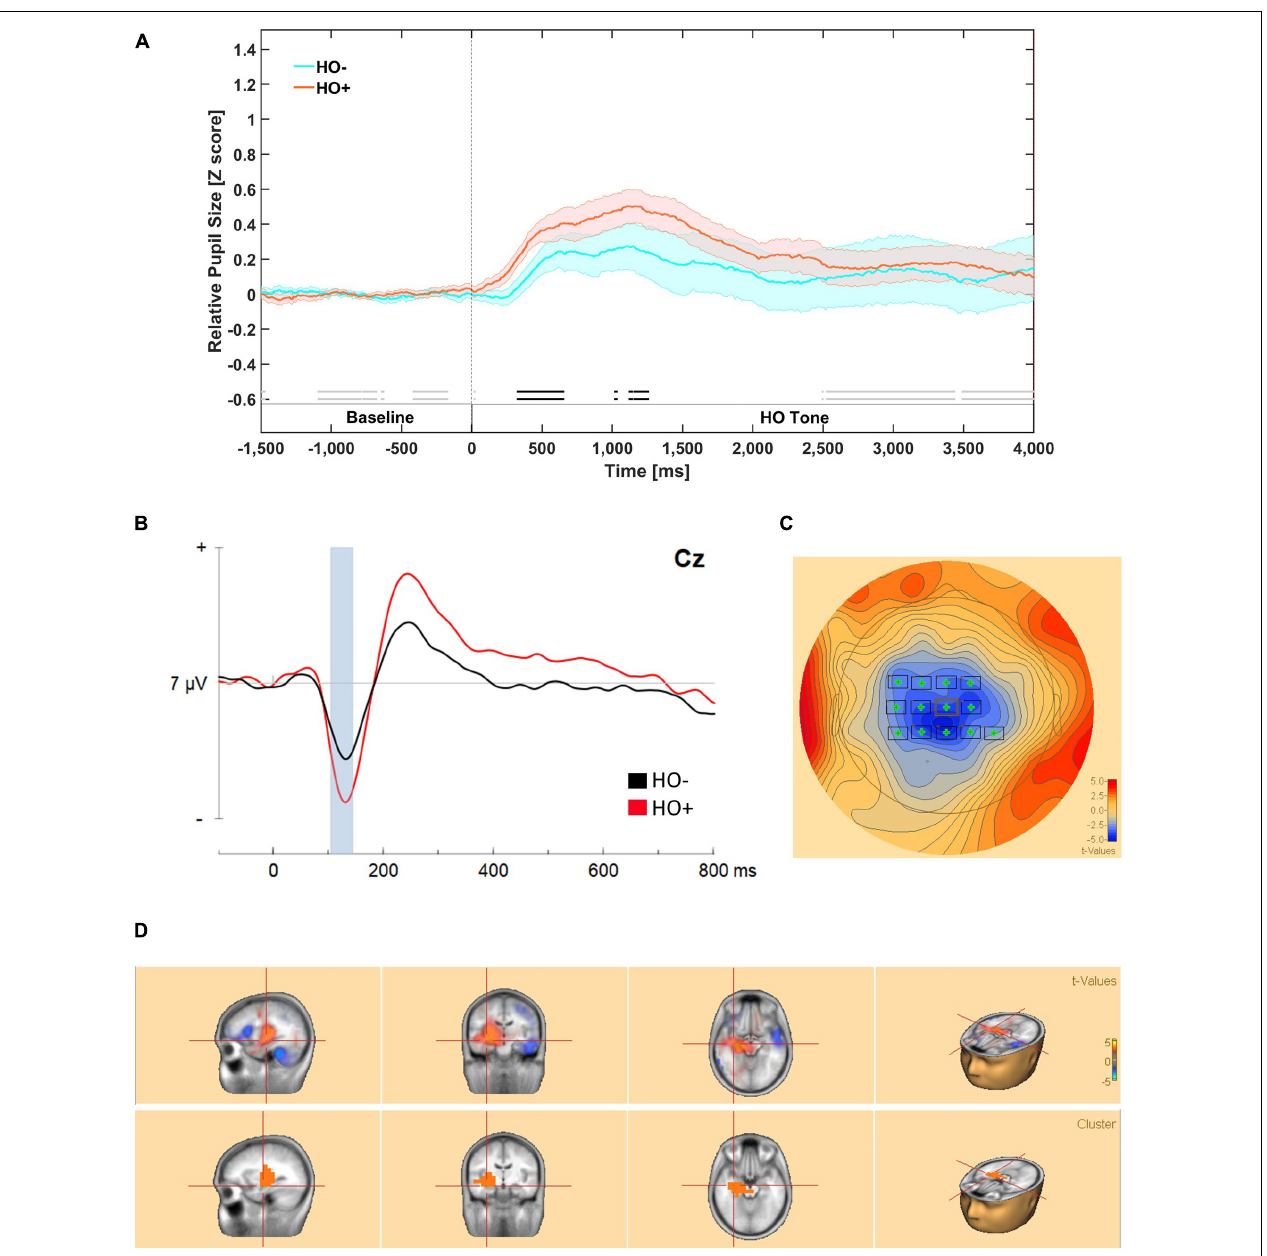
FIGURE 3 | (A) Mean relative pupil dilation ( z -score) responses during higher-order tone presentation in phase 5. Meaningful differences (BF 10 ≥ 3) are indicated for by an opaque double line near the bottom of the figure above the segment labels. Evidence in favor of the null hypothesis is indicated by faded double line near the bottom of the figure. Meaningful differences are observed from 400 to 1500 ms post-stimulus onset. The dark line in color represents the mean of that condition (orange for CS+/US+ trials and blue for CS–/US– trials). The lighter color bands surrounding the darker colored lines represent Standard Error of the Mean. (B) Evoked responses to higher order tones revealed from bootstrap cluster analysis. Evoked responses waveform measured at Cz to higher order tones. Bootstrap cluster analyses revealed a significant difference from 100 to 155 ms. (C) Mean potential distribution map averaged across participants ( n = 14) at scalp level.